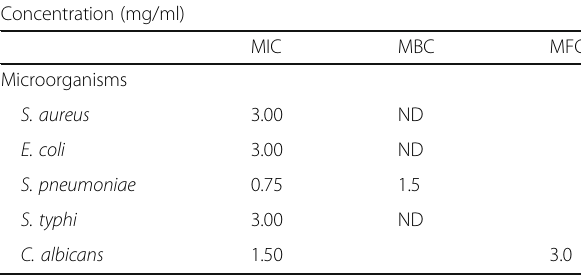
Table 3 Summary of MIC, MBC and MFC of the isolate (mg/ml